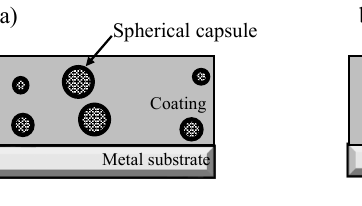
Figure 13. Schematic illustration of the structural change in SHC-SFC by physical damage . ( a ) Just before damage, polyurethane coating with dispersed spherical and fi brous capsules. ( b ) Just after damage, fl owing-out of healing agent from broken capsules to damaged area. ( c ) At the last stage of aging, repairing the coating in the whole damaged area with a self-healing structure. In previous investigations [26], porous-type anodic oxide fi lms were formed on Al alloys, and nano-pores were fi lled with a solution containing a corrosion inhibitor before being covered with organic coatings. The specimen was physically damaged with a cu tt er blade, and corrosion tests were carried out in 1.57 mM–CuSO 4 /0.57 M–KCl solution for 24 h at room temperature. The corrosion protection e ff ect appeared just after physical dam- age by the inhibitor that fl owed out from the nano-pores to the damaged area, but the system could not achieve thorough protection. This might be due to the fast adsorption of the inhibitor on the surface of the damaged area at a low concentration. Conclusively, the corrosion protection ability of the self-healing coating on the Al alloy substrate heavily depends on systems and the shape of capsules dispersed in the coating. Fibrous capsules were aligned parallel to the surface during aging of the coating, and a large amount of healing agent fl owed out from the broken capsules after damage to repair the scar thoroughly.